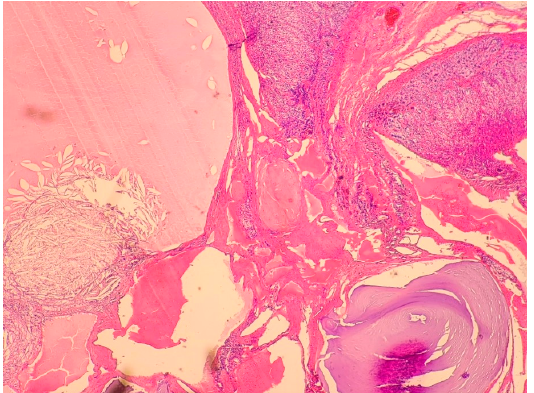
Figure 6. Multilocular endothelial cyst lined by endothelial cells with septal calcifications. In the lumen of the cyst, eosinophilic masses and cholesterol clefts are visible. The lesion probably represents dilated blood vessels with organized thrombi. Hematoxylin & eosin, 40× magnification.